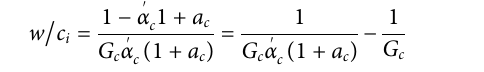
FIGURE 2 | Porosity distribution in steel-concrete interfacial zone and aggregate-paste interfacial zone (Horne et al., 2007).